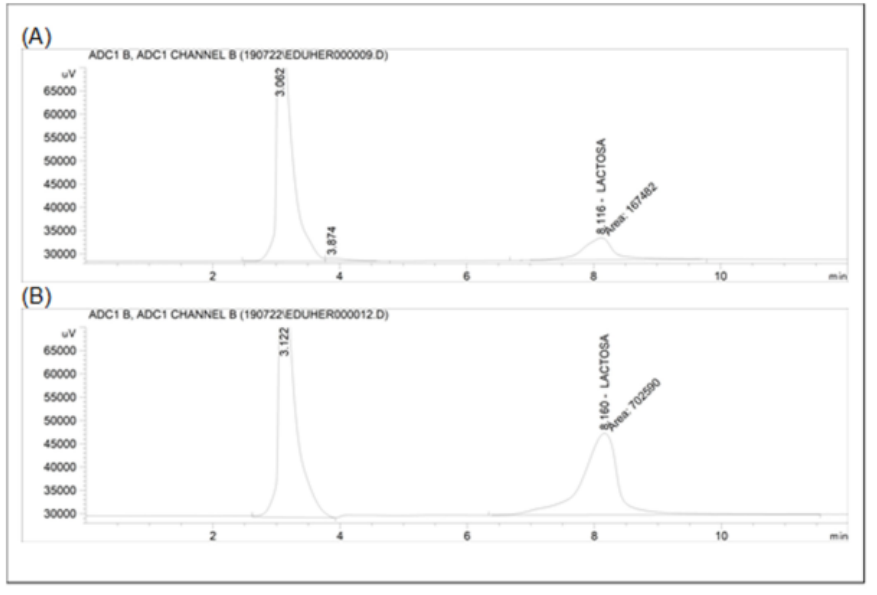
Figure 3. Lactose chromatograms of initial ( A ) and concentrated whey ( B